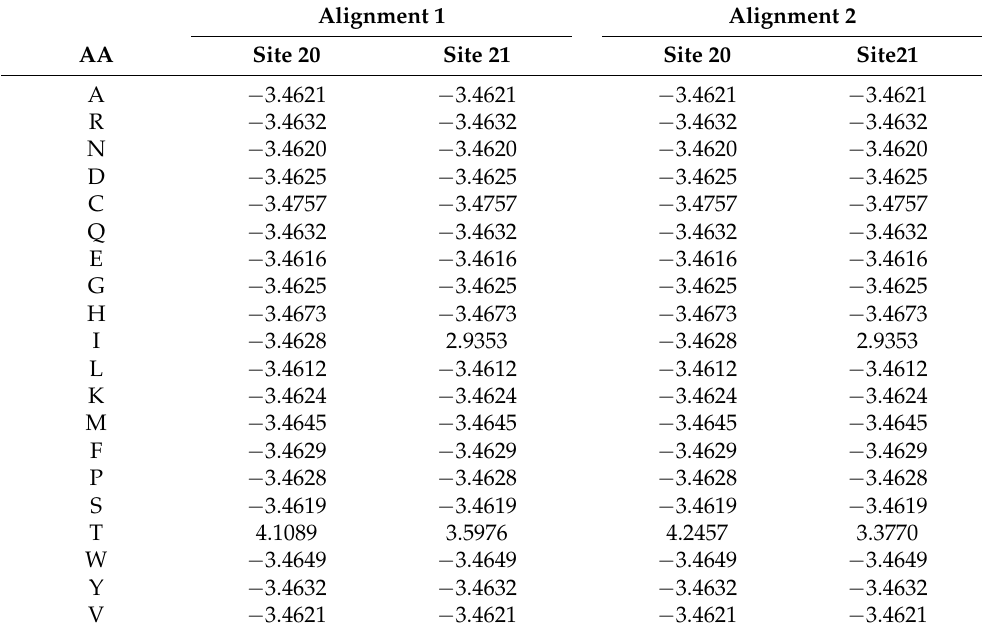
Table 2. Partial position weight matrix for 11 aligned ACE2 sequences, generated from DAMBE [40] using default options for pseudocounts and background frequencies. Only sites 20 and 21 are